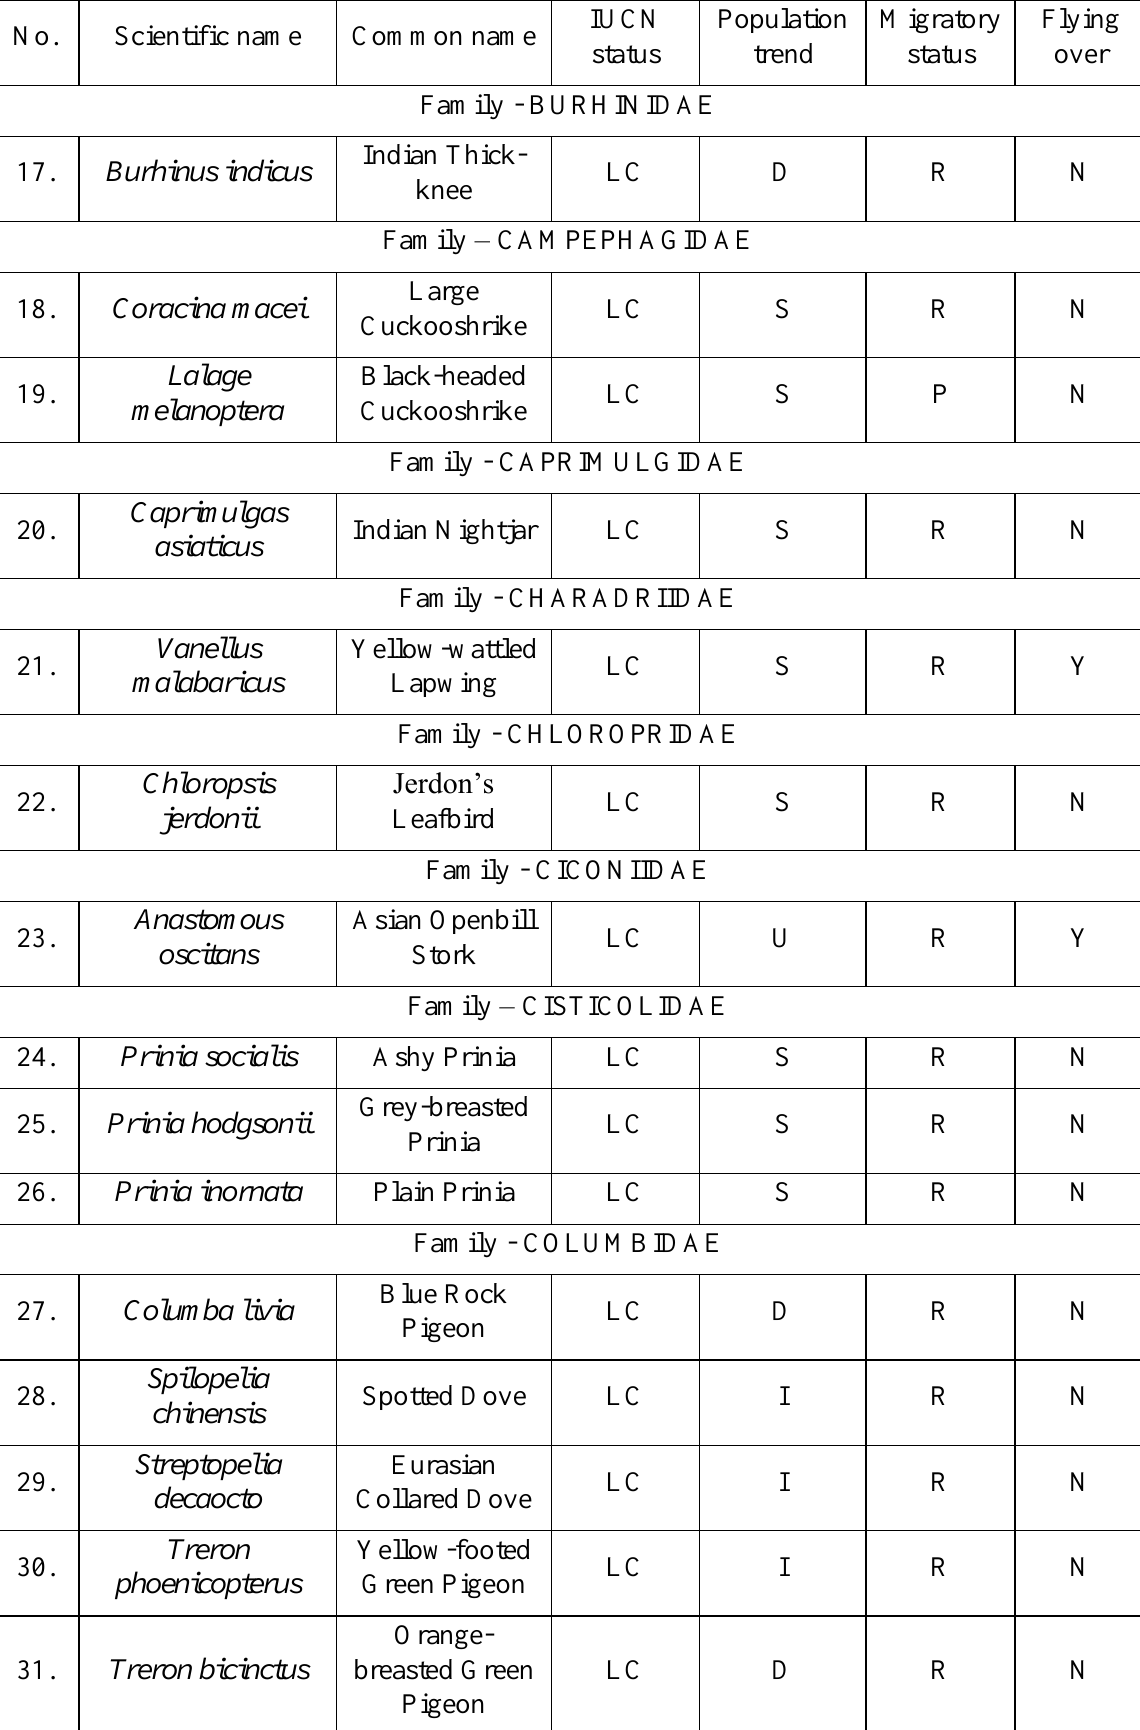
Table 1. List of bird species recorded in Durgapur Government College Campus